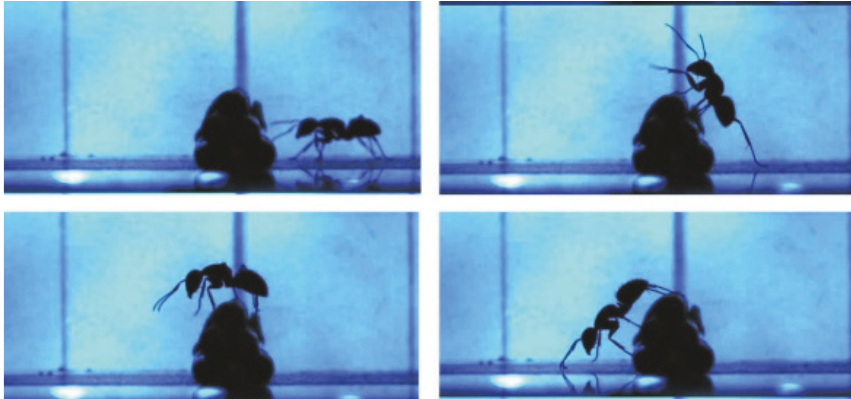
Figure 9: The snapshot of obstacle crossing.